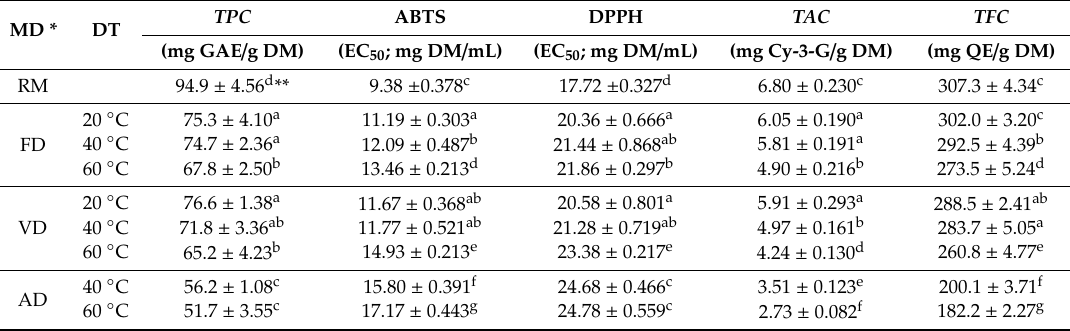
Table 9. Profileand antioxidant activity of dried leaves from Moldavian